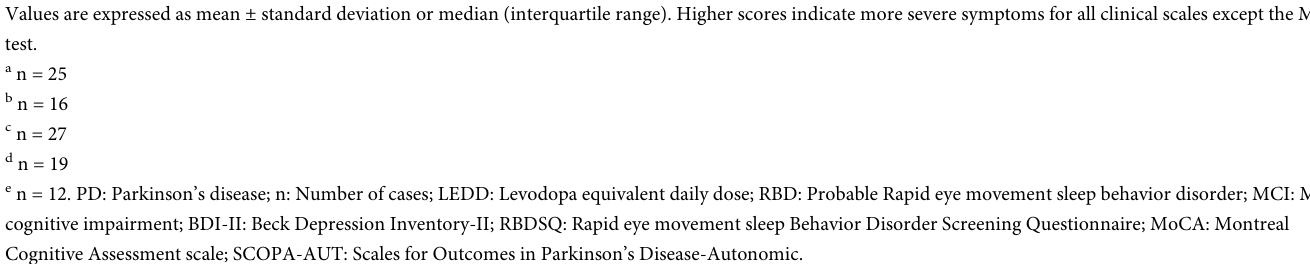
females versus 23% of males did not experience Tenderness at all (mean concordance = 0; Yates corrected χ 2 = 0.24, p = 0.62). Instead, some of these patients reported having felt Sad- ness (11%), Amusement (11%) or Anger (6%) in response to tender scenes, which differed sig- nificantly from the overall rate of emotional responses other than Tenderness reported by the healthy controls in the same affective setting, excluding the Neutral State (34% in the PD group vs . 13% in the control group; Pearson χ 2 = 4.16, p = 0.04). For instance, no healthy par- ticipant experienced feelings of Anger in response to the stimuli intended to elicit Tenderness. On the whole, patients reported a higher rate of no emotional experience (Neutral State) when exposed to an affective context (22% in the PD group vs . 11% in the control group; Pearson χ 2 = 8.30, p = 0.004). The affective protocol was significantly more effective in eliciting feelings of Amusement in the study participants than those of any other emotion (target emotion effect; Friedman ANOVA χ 2 = 13.71, p = 0.008). In the healthy participants, sad films mostly elicited pure or mixed feelings of Sadness (62%) and Anger (53%); disgusting films mainly elicited